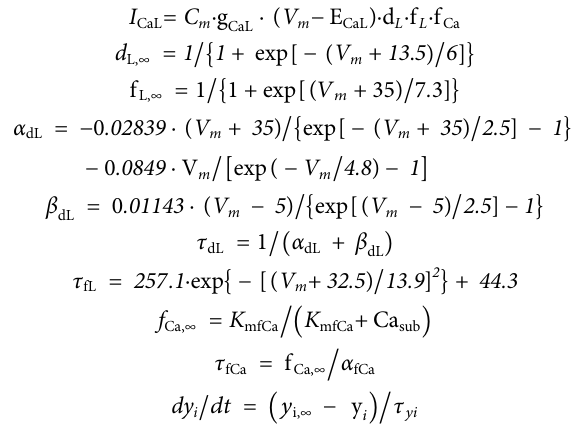
FIGURE 2 | A schematic illustration of SAN tissue structure and calculation of the network voltage ( V net ) for a cell with index n in Campana model (Campana, 2015). Pink squares denote individual SAN cells (Maltsev- Lakatta models) located at the nodes of a square grid. The cells interact via intercellular conductances placed uniformly at the grid ’ s edges (shown by blue double-headed arrows). V net is the sum of voltages from the four neighboring cells (right, left, up, and down). Shown is only a 3 × 3 section the network;the tissue continues beyond thedash lines toform theentire 25×25 cell network used in our